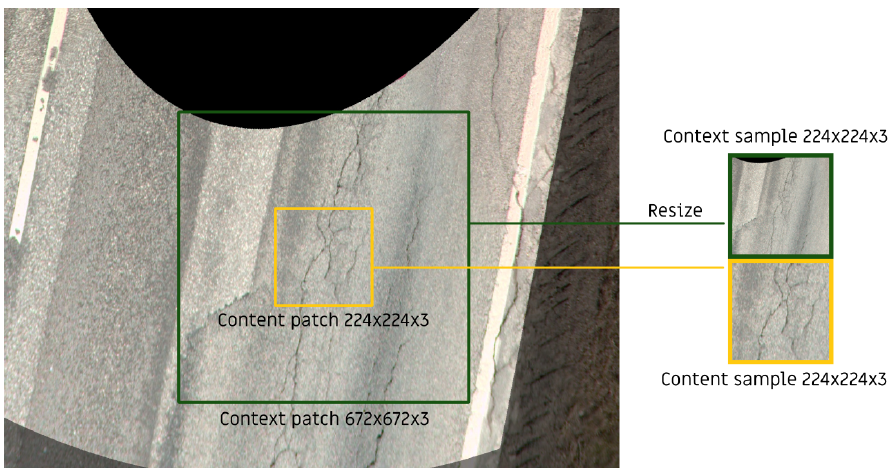
Figure 6. Extraction of a content-context sample from an orthoframe.